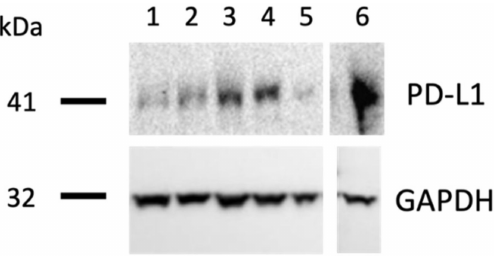
Figure 5. PD-L1 expression level on in ovo xenografted H460 tumors. Representative Western blot of H460 tumors collected at EDD16. Lane 1: tumor 1, lane 2: tumor 2, lane 3: tumor 3, lane 4: tumor 4, lane 5: tumor 5, and lane 6: positive control. Human GAPDH was used as the internal control. Samples were loaded on the same membrane, but lanes were rearranged for the purposes of the figure. The original uncropped WB image is presented in Supplementary Figure S1.